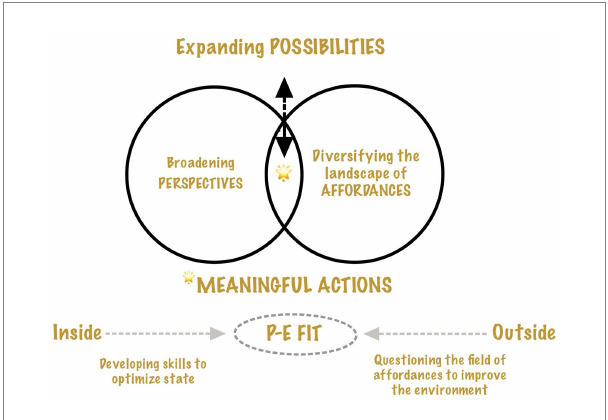
FIGURE 2 A Person–Environment (P–E) fit model of high-performance